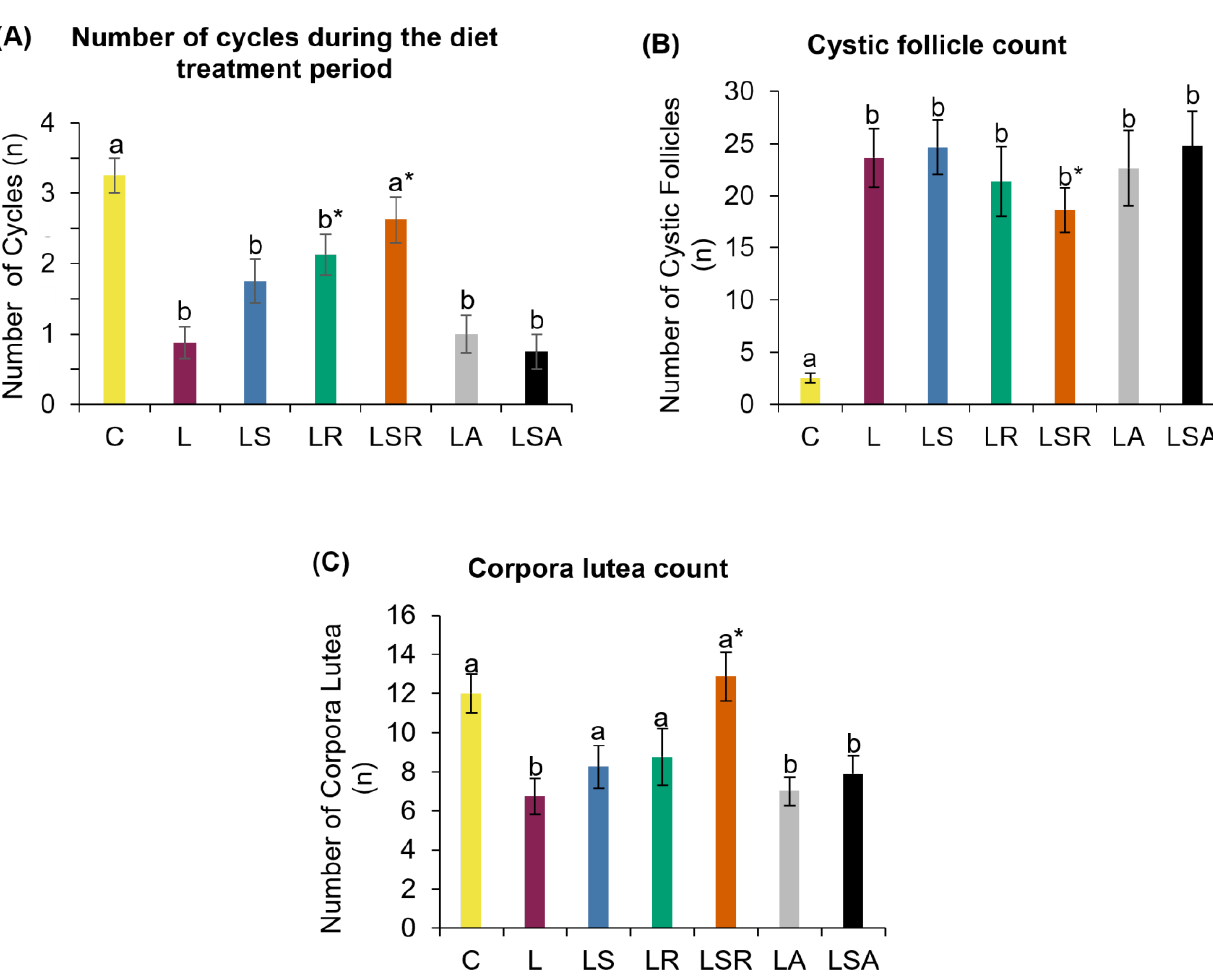
Figure 2. Analyses of menstrual irregularity and polycystic ovaries. ( A ) Number of cycles present during the diet treatment period. This analysis was performed to measure menstrual irregularity. Vaginal cell suspensions were collected daily and stained using Modified Wright–Giemsa stain to identify the cycle stage on each day. The number of cycles was counted during the 21-day diet treatment period. ( B ) Cystic follicle count and ( C ) corpora lutea count were measured using ovarian histological analysis. Excised ovaries were embedded in paraffin blocks, and the sections were stained using hematoxylin – eosin stain. All the values are expressed as the mean ± S.E. Statistical analysis was conducted by one-way ANOVA followed by Dunnett’s test for multiple comparison analysis. a, b represent p < 0.05 compared to the C group, * represents p < 0.05 compared to the L group.